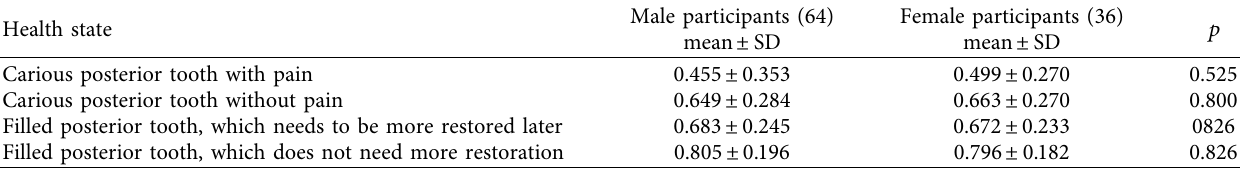
Table 2: Comparison between male and female participants regarding health status.